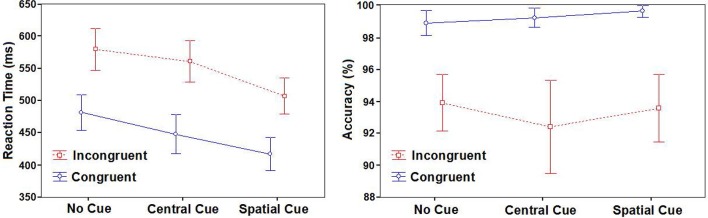
Behavioral results. Mean reaction times (in milliseconds) and accuracy (in percentages) with standard deviations according to cues and targets.